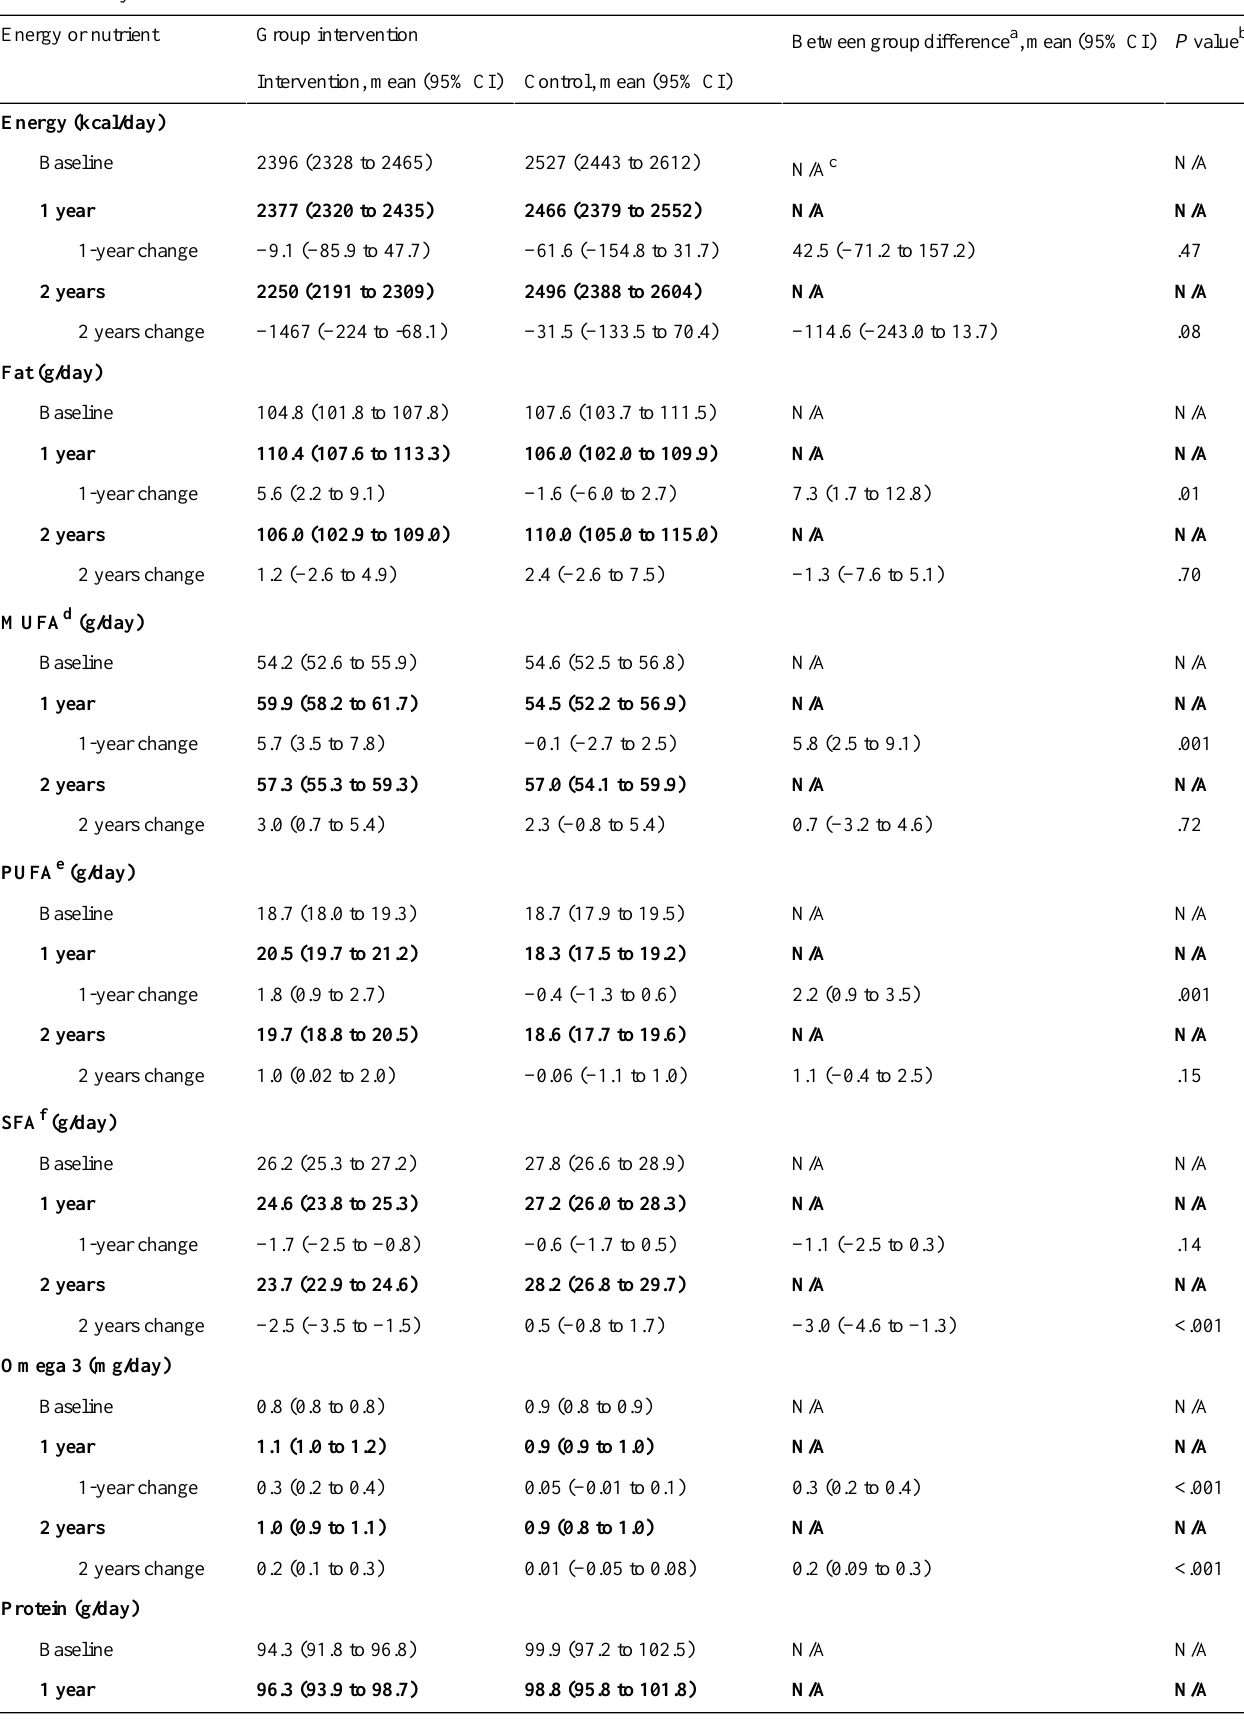
Table 3. Baseline nutrient intake and changes by randomized treatment group at 12- and 24-month follow-up visits of participants in the prevention of recurrent arrythmias with Mediterranean diet